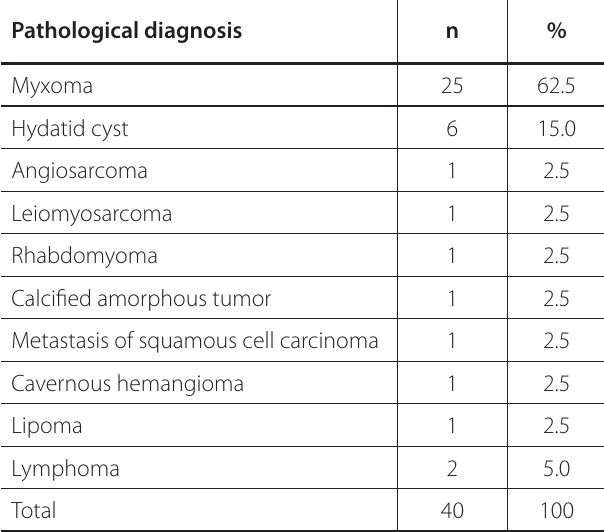
Table 3 . Masses and rates. Pathological